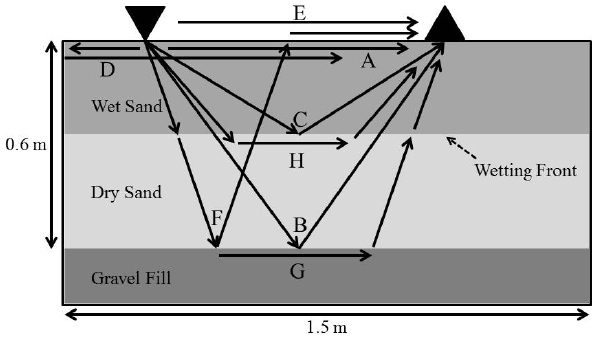
Fig. 4. Raypaths for selected arrivals discussed in the paper. Ar- rivals shown here include the groundwave (A), bottom of sand re- flection (B), wetting front reflection (C), side of tank reflection (D), airwave (E), air-refracted bottom of sand reflection (F), refraction through the gravel layer (G), and wetting front refraction